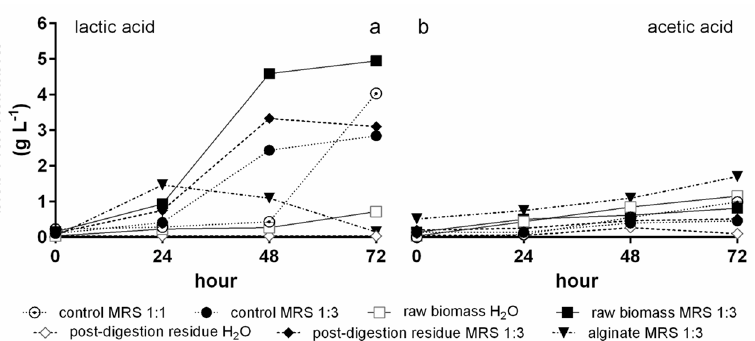
Figure 5. Organic acid production during fermentation. Production of lactic ( a ) and acetic ( b ) acid by L. plantarum ATCC 8014 in the controls (MRS 1:1, MRS 1:3), in the alginate control in MRS 1:3, and with T. lutea F&M-M36 raw biomass and post-digestion residue in the two matrixes (H 2 O and MRS 1:3). Data are expressed as mean ± standard error.